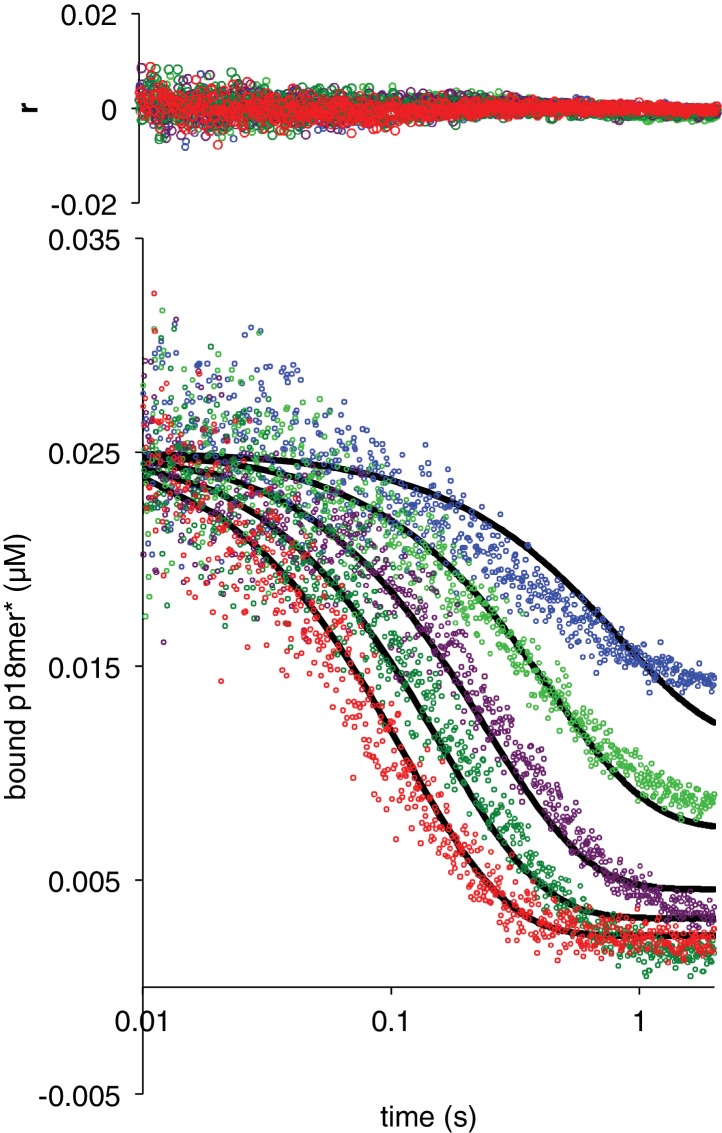
Dissociation of ΔZn1 from p18mer*.Global fits of five representative concentrations of competitor DNA are shown: 0.15 µM (blue), 0.4 µM (light green), 1 µM (violet), 2 µM (dark green), and 4 µM (red) to the kinetic mechanism in Scheme 3. Residuals for the five concentrations are shown overlaid in the corresponding colors above each plot.10.7554/eLife.37818.033Figure 4—figure supplement 3—source data 1.Dissociation of ΔZn1 from p18mer*.